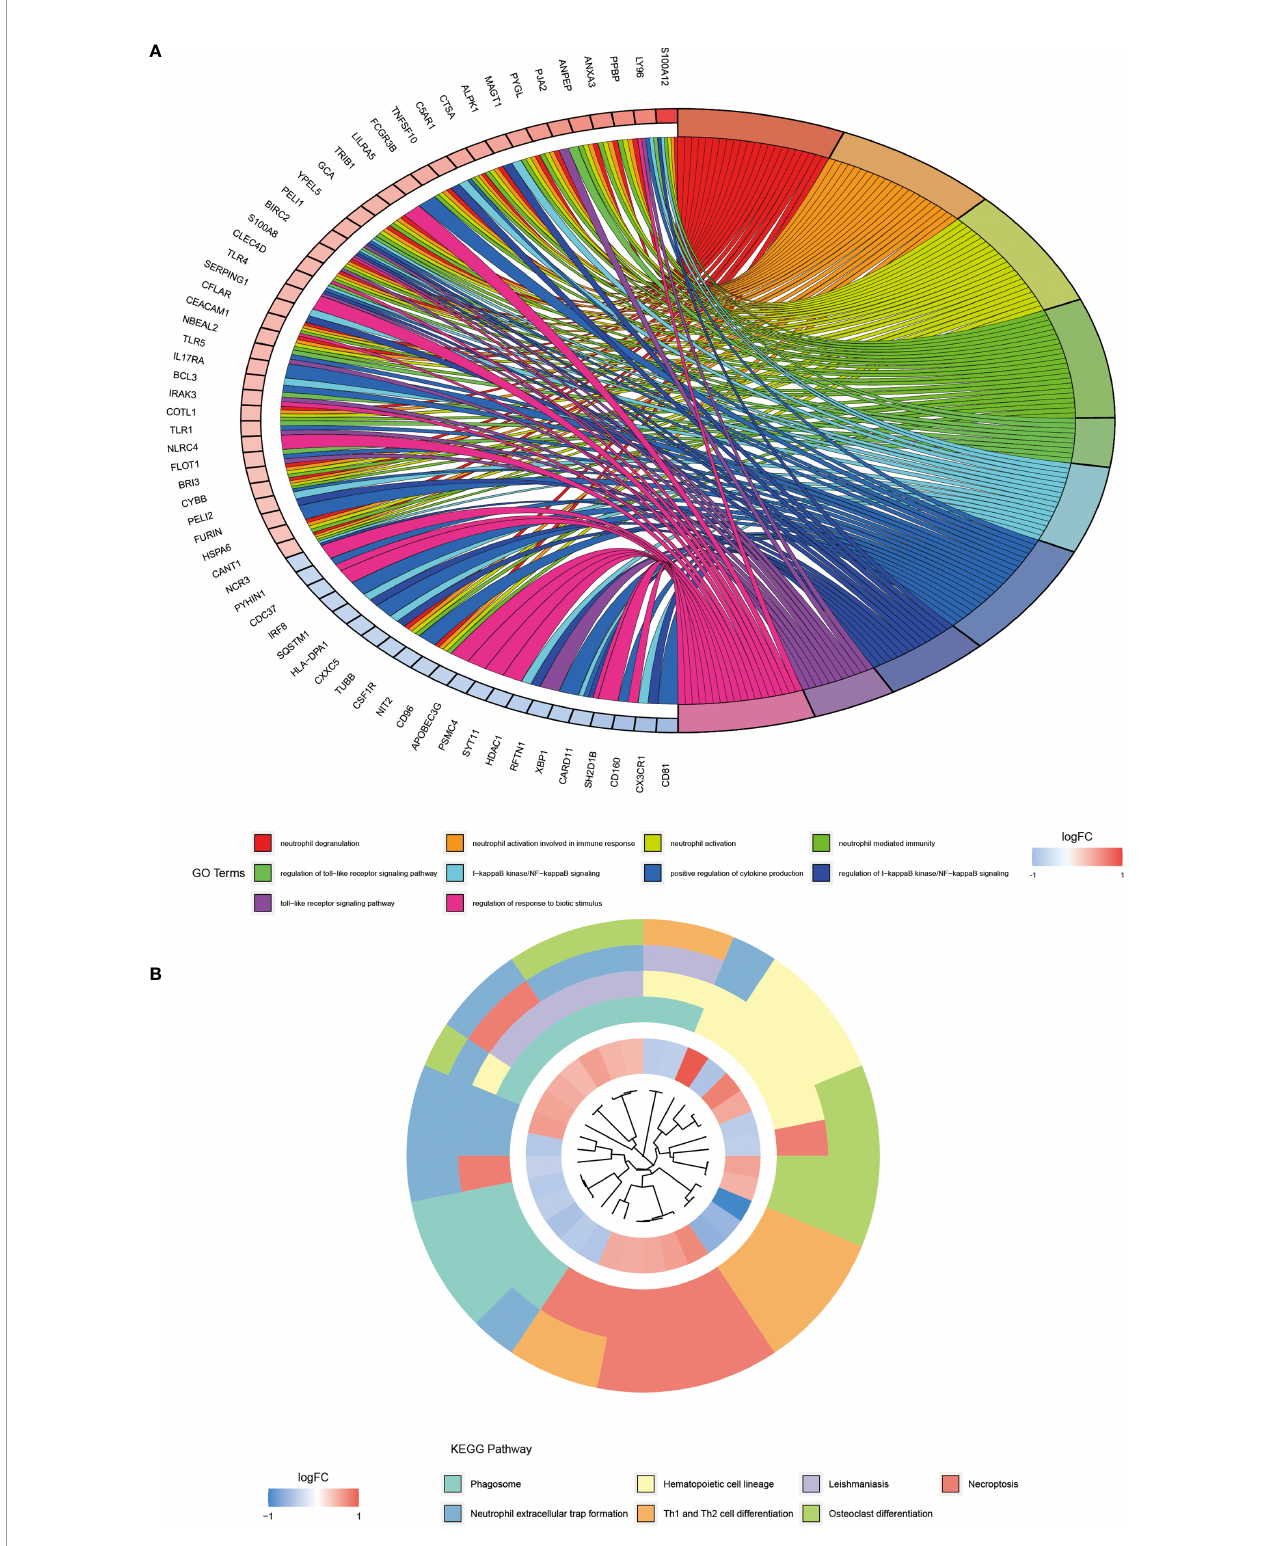
FIGURE 2 | GO and KEGG pathway enrichment analysis of differentially expressed genes. (A) shows the fi rst 10 entries of GO enrichment analysis of differentially expressed genes. (B) shows the top 7 pathways of KEGG